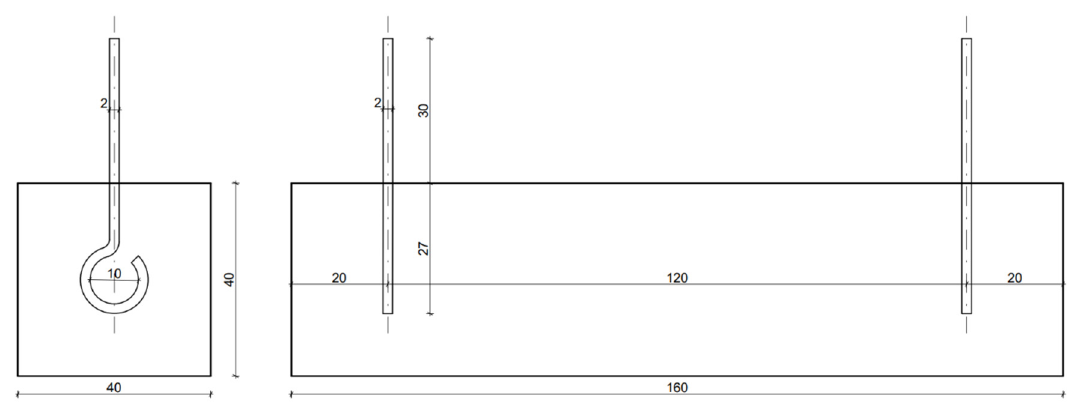
Figure 3. Scheme of the test specimen.